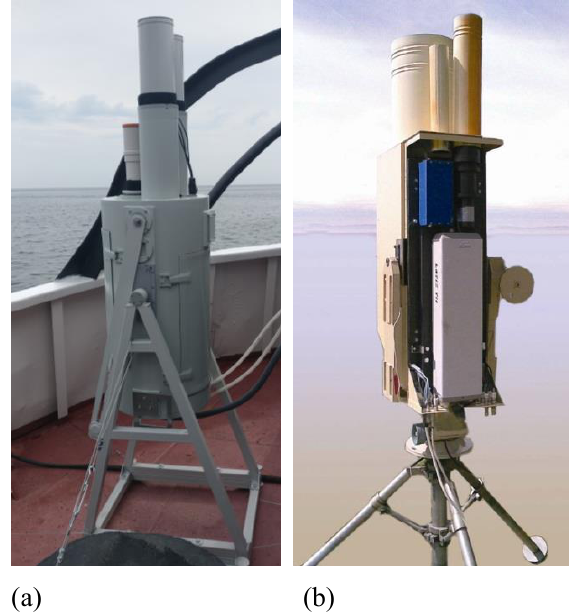
Fig.1 Appearance of mobile aerosol-Raman lidars « LOSA-A 2» (a) and « LOSA-M 2» (